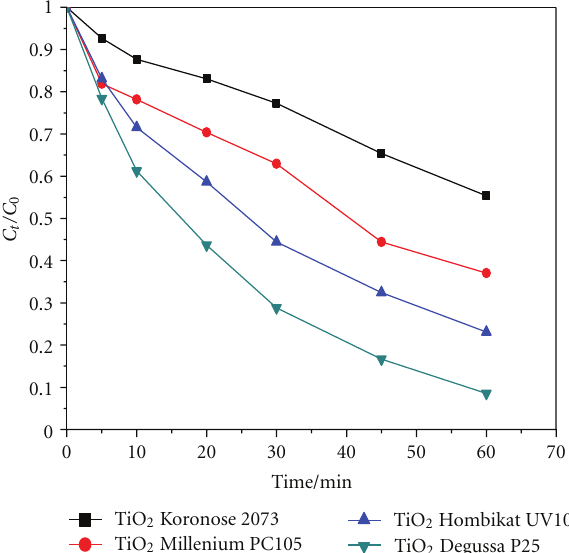
Figure 10: Photodecolorization of cobalamin by di ff erent types of